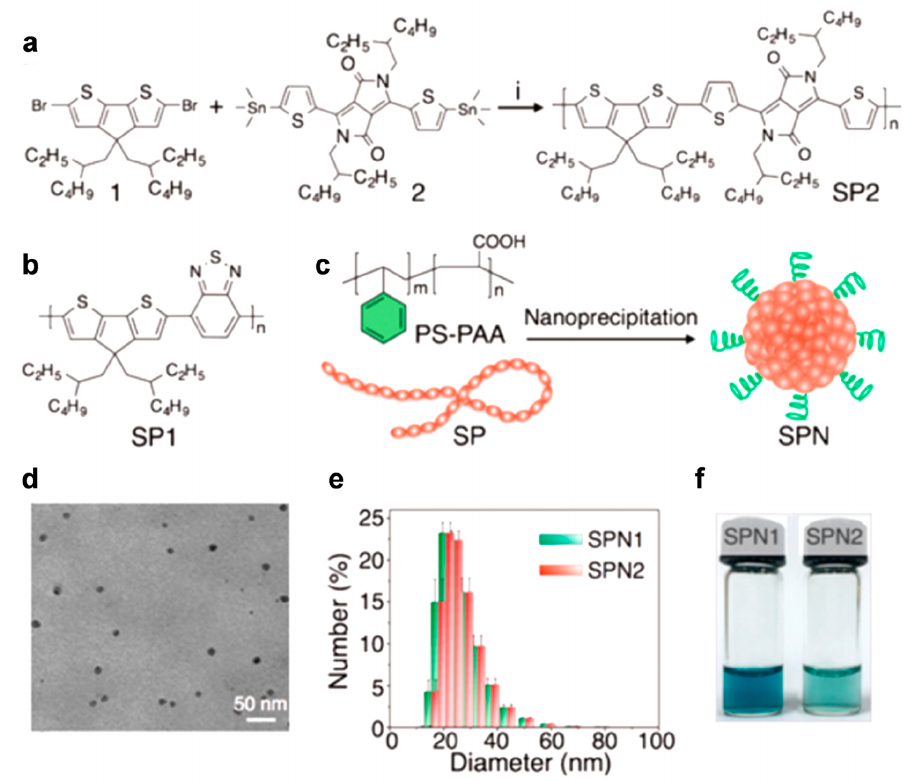
Figure 7. Synthesis and characterization of semiconducting polymer nanoparticles (SPNs). ( a ) Synthetic route of SP2 via Stille polymerization under the reaction conditions ( i ) PdCl 2 (PPh 3 ) 2 and 2,6-di- tert -butylphenol, 100 ◦ C for 12 h. ( b ) Chemical structures of SP1. ( c ) Schematic illustration of synthesis of SPNs. ( d ) Representative TEM image of SPNs: SPN2. ( e ) Representative dynamic light scattering (DLS) profiles of SPNs. ( f ) Photos of SPN solutions (18 µ g · mL − 1 ). Reprinted with permission from [74]. Copyright, American Chemical Society